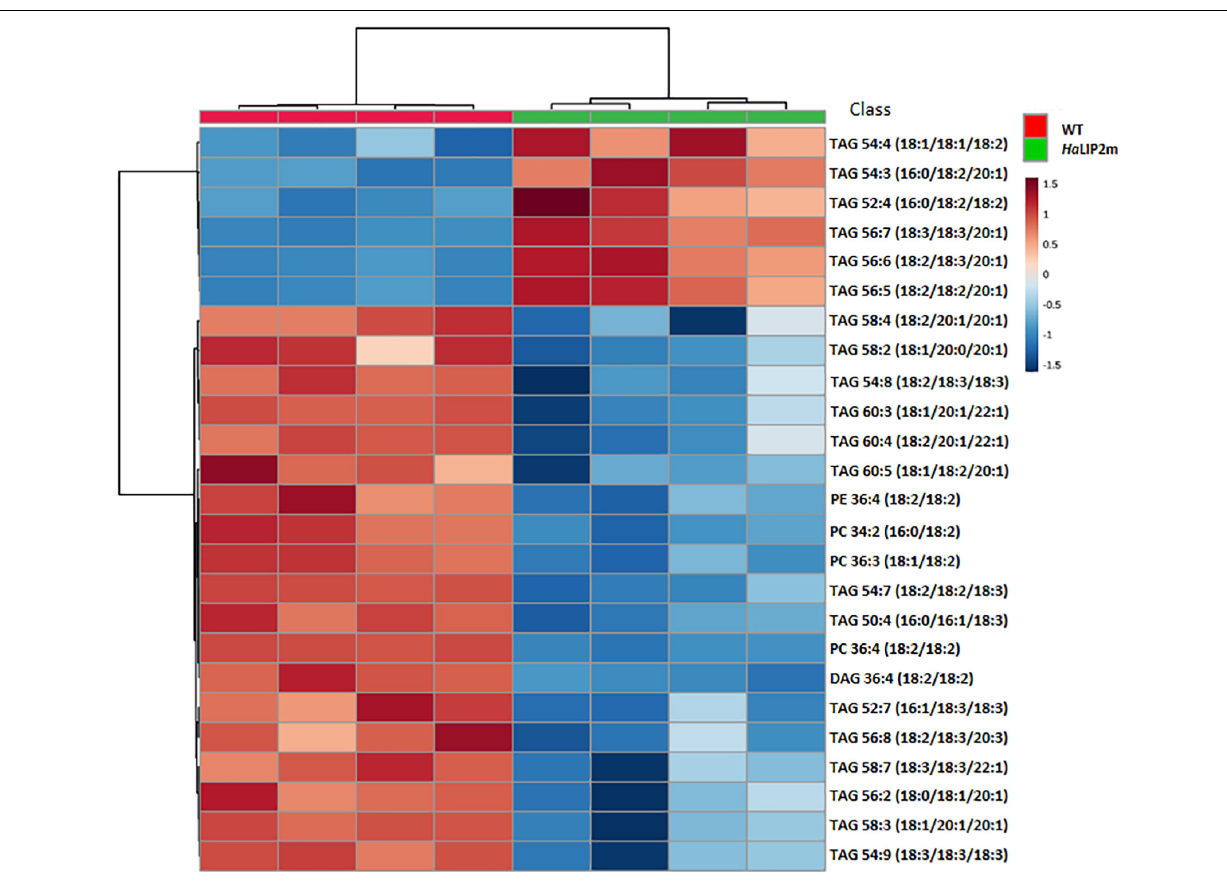
FIGURE 11 | Hierarchical clustering and heatmap of the most significantly different lipid species (right) comparing mature control (WT, in red) and transgenic HaLIP2m seeds (blue). TOP 25 p < 0.05 t